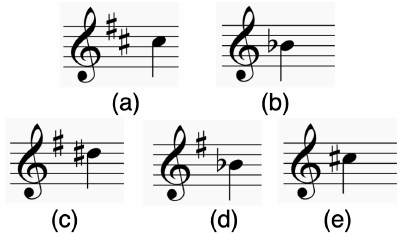
Figure 7. ( a , b ) Examples of ambiguous key signatures. ( c – e ) Cases where key signature